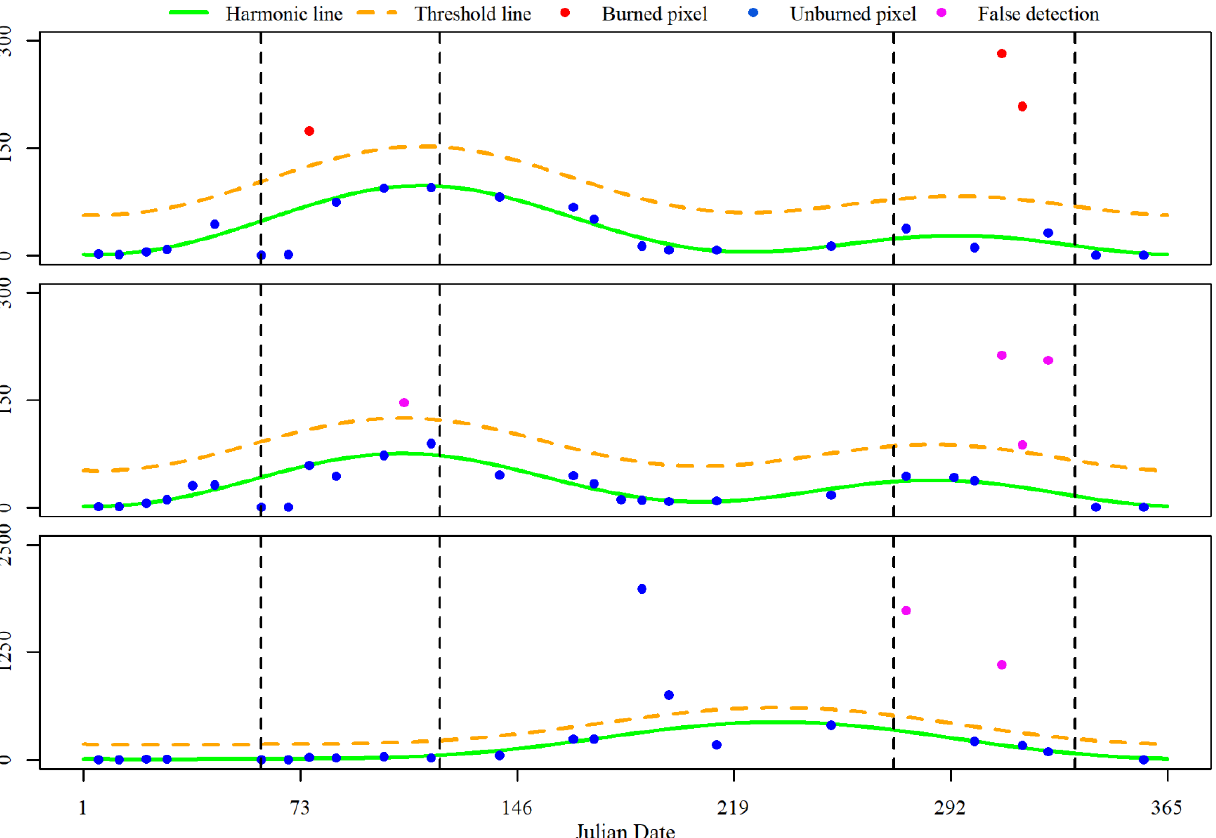
Figure 6. Demonstration of cropland burned area detection with different land cover types using multi-harmonic model fitting. The red points, blue points, and pink points represent cropland burned pixels, unburned pixels, and false detections, respectively. The vertical black dashed lines are the boundaries of the fire seasons.